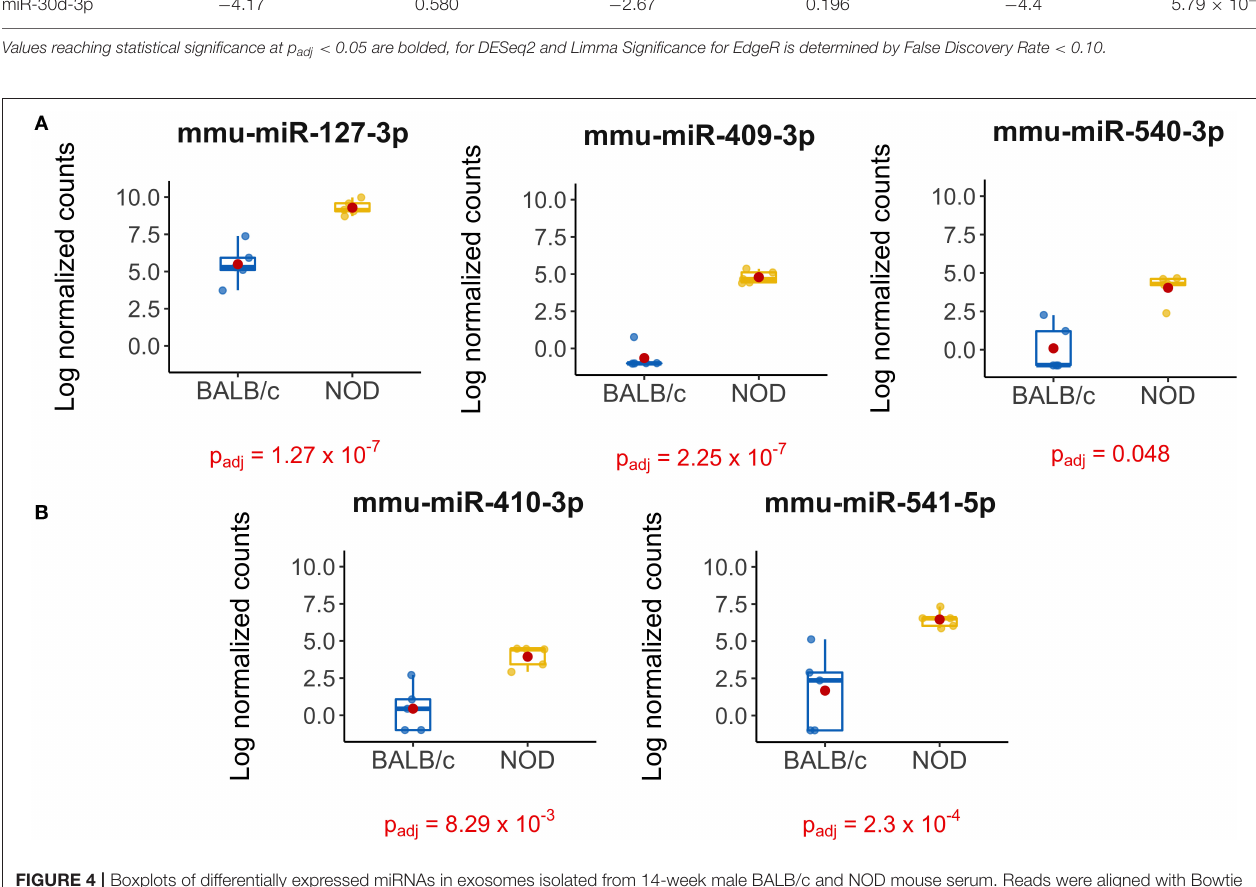
FIGURE 4 | Boxplots of differentially expressed miRNAs in exosomes isolated from 14-week male BALB/c and NOD mouse serum. Reads were aligned with Bowtie and an in-house brute force-based aligner, and differential gene expression analysis was conducted using DESEq2, EdgeR, and LimmaVoom in RStudio. (A) Both DESeq2 and LimmaVoom identified miR-127-3p, miR-409-3p, and miR-540-3p as “hits” with p adj < 0.05. (B) Additionally, LimmaVoom identified miR-410-3p and miR-541-5p to be dysregulated with p adj < 0.05. miR-329-5p failed to reach statistical significance due to one outlier but exhibited the highest fold change with Log 2 FC > 5 in EdgeR and DESEq2. Results were obtained from data sets generated from small RNA sequencing of 5 sets of RNA from exosomes from each mouse cohort, each isolated from purified pooled serum exosomes from five groups of age-, gender-, and strain-matched mice, with 5 mice per